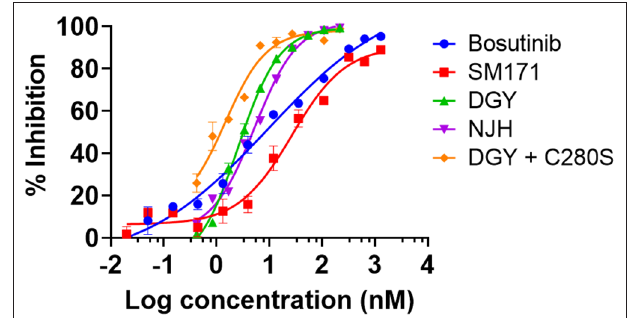
FIGURE 2 | DGY-06-116 inhibits Src enzymatic activity. DGY-06-116 potency at 1h exceeds SM1-71 and bosutinib. However, a non-covalent analog NJH-01-111 also shows potent activity. DGY-06-116 also potently inhibits Src C280S . Error bars are the standard deviation of three replicates.